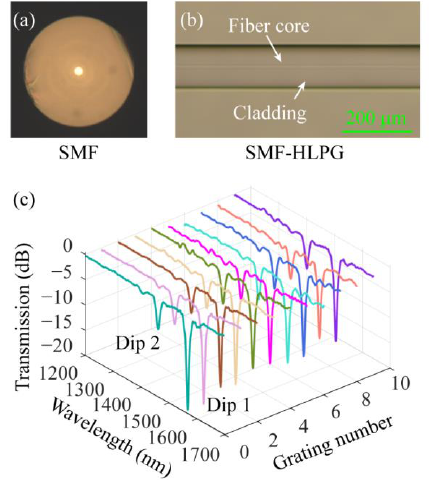
Figure 10. ( a ) Microscopic image of the cross-section of the SMF. ( b ) The microscopic image of the partial SMF-HLPG. ( c ) The transmission spectra of different SMF-HLPG samples. The changes of Dip 1 in the transmission spectra of SMF-HLPGs were evaluated.